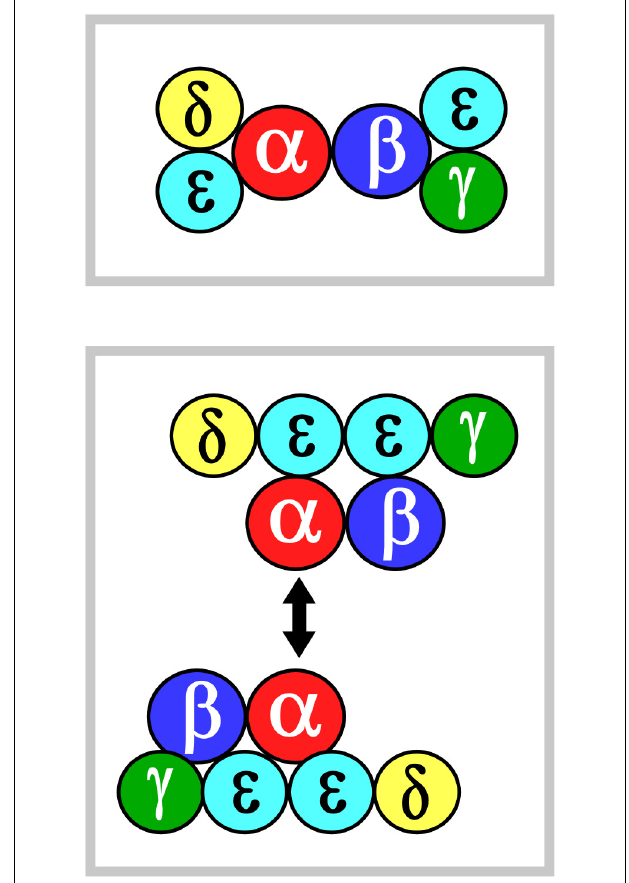
FIGURE 1 | αβ TCR complex subunit ectodomain topology. Two models of the topology are shown in the top and bottom panels, termed models 1 and 2, respectively.These are viewed from above theT cell looking down. Color coding for the CD3 components are green, yellow and mint for CD3 γ , CD3 δ , and CD3 ε , respectively.TCR α is in red andTCR β is in blue.The CD3 ζζ homodimer is omitted since it lacks an ectodomain structure. In model 2, the two-headed arrow is meant to indicate that C α –C α interaction dimerizes twoTCR complexes (Kuhns etal., 2010). See the text for